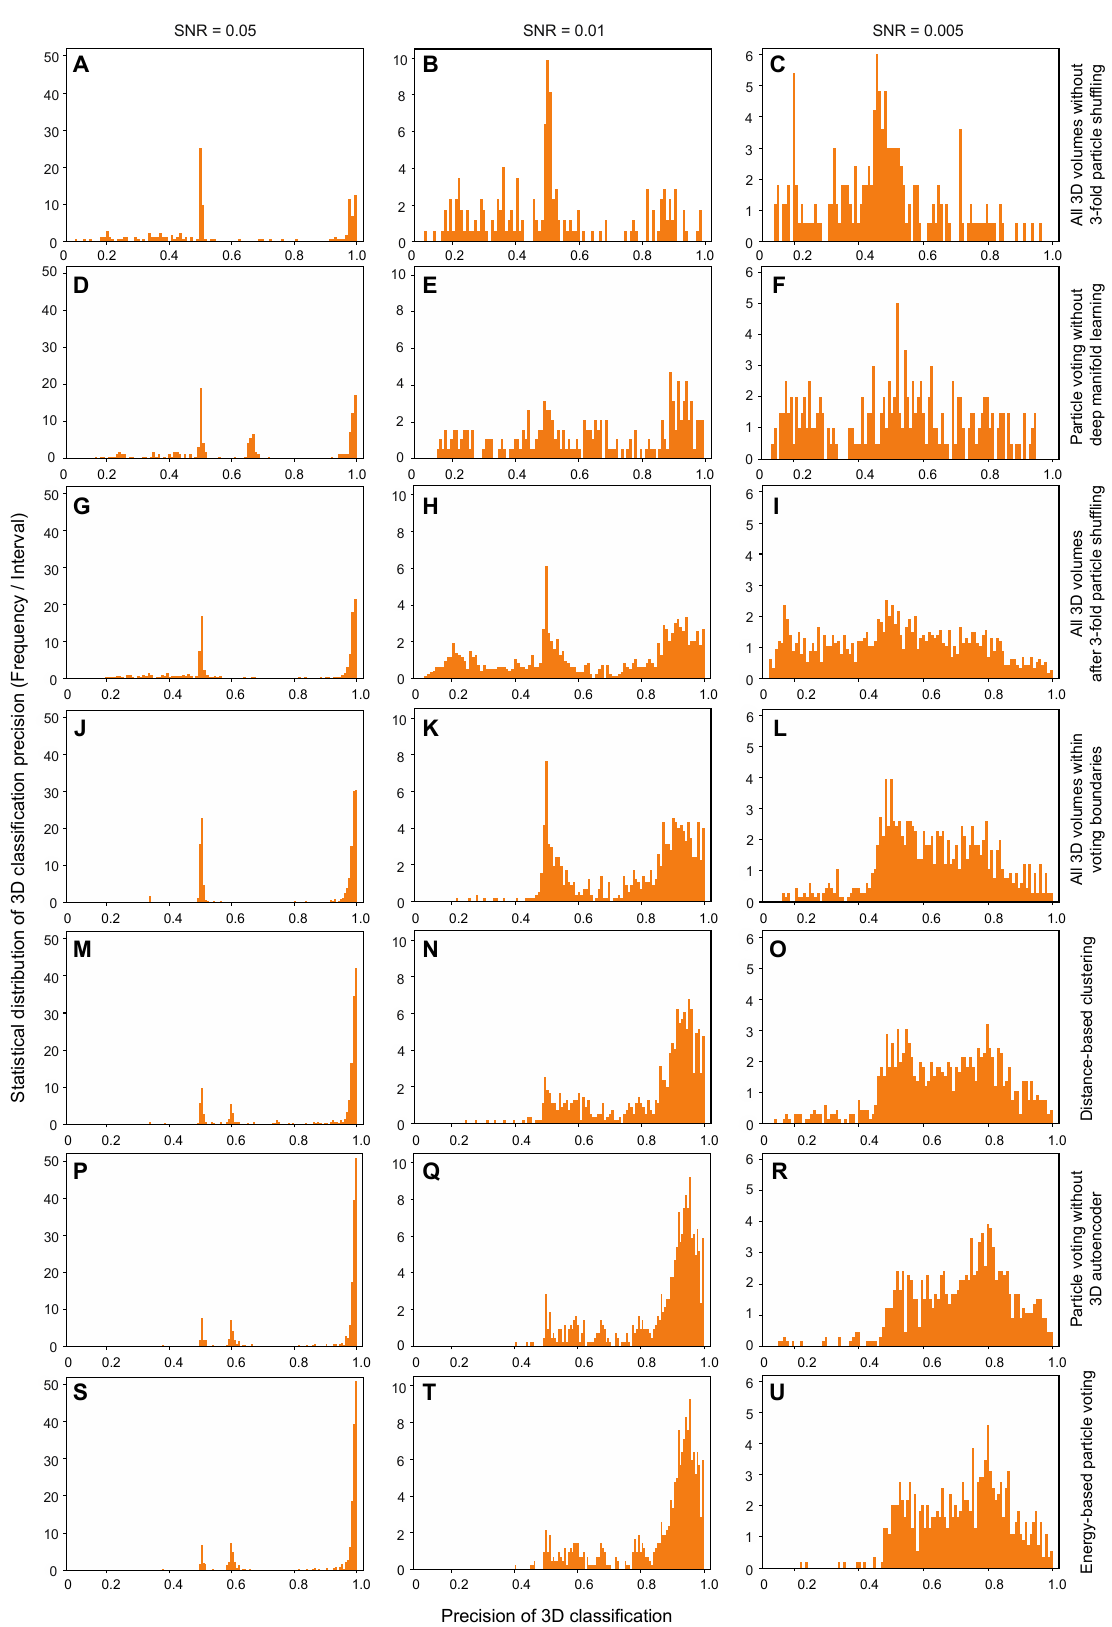
Figure 5. Mechanistic characterizations of the improvement of 3D classification accuracy by Al- phaCryo4D using the simulated NLRP3 datasets of three typical SNRs. Left, middle and right